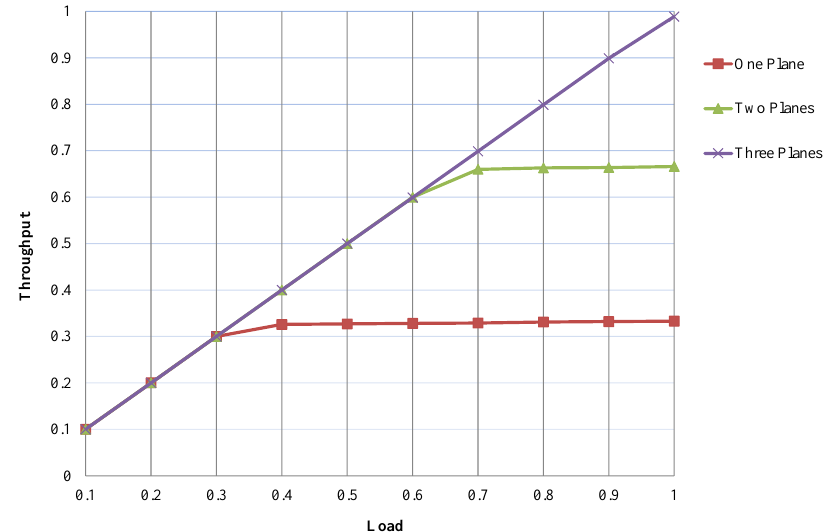
Figure 16. Throughput of optical tunnel switching network with 49 nodes.